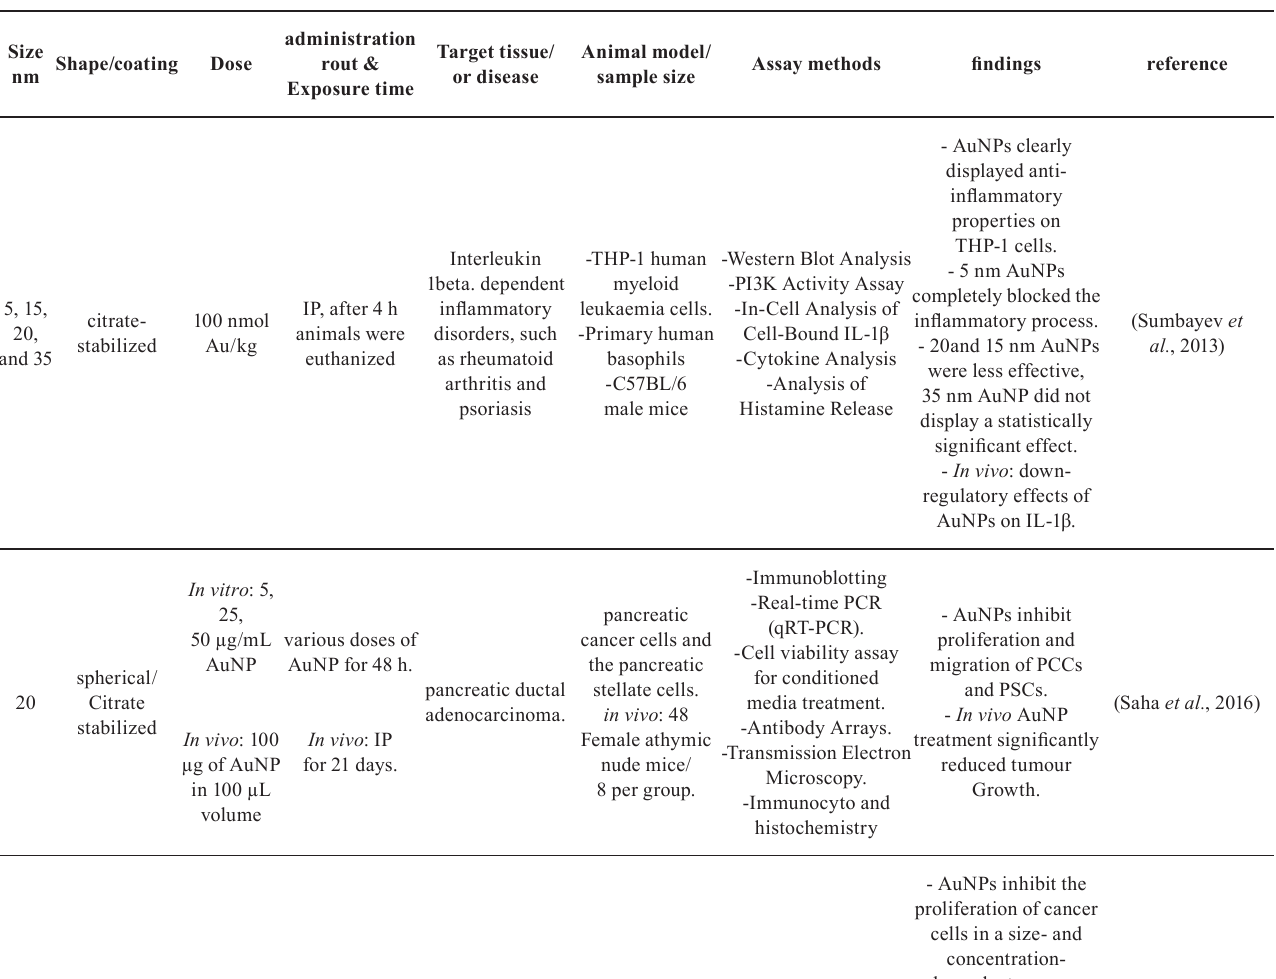
TABLE II – Therapeutic effects of Gold nanoparticles on different disorders